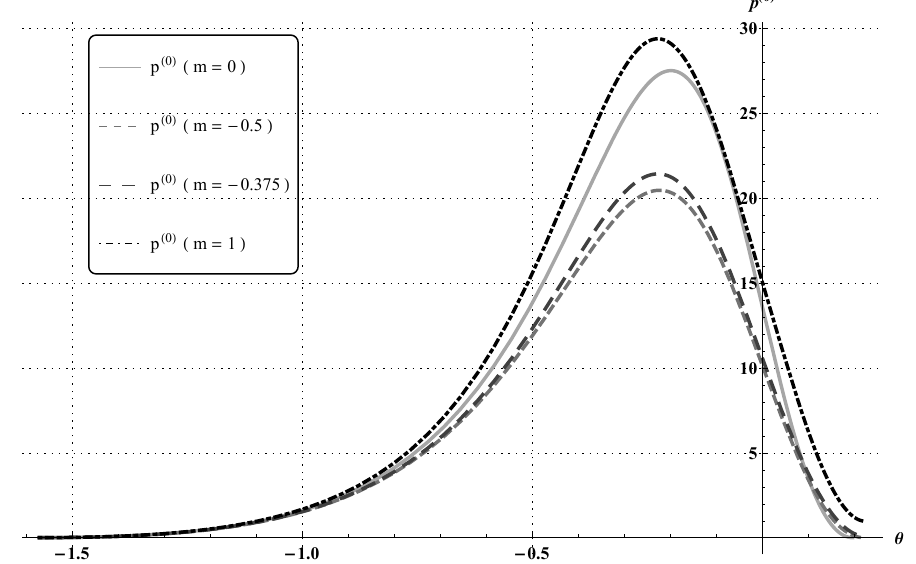
Figure 4. Pressure distributions computed from the classical Reynolds equation, p ( 0 ) ( θ ) ( m = 0 ) , and from the power-law system of Reynolds type equations, p ( 0 ) ( θ ) ( m = − 0.5, − 0.375,1 ) , with (cid:101) = 0.1 and α 0 = O ( (cid:101) 2 ) .